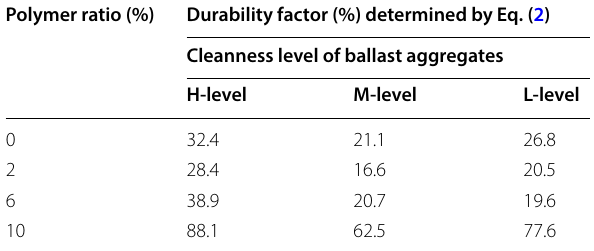
Table 6 Durability factors of the twelve concrete samples. Polymer ratio (%) Durability factor (%) determined by Eq. (2)